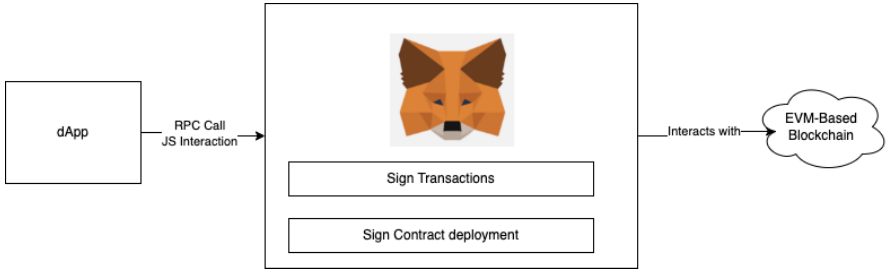
Figure 3. Metamask